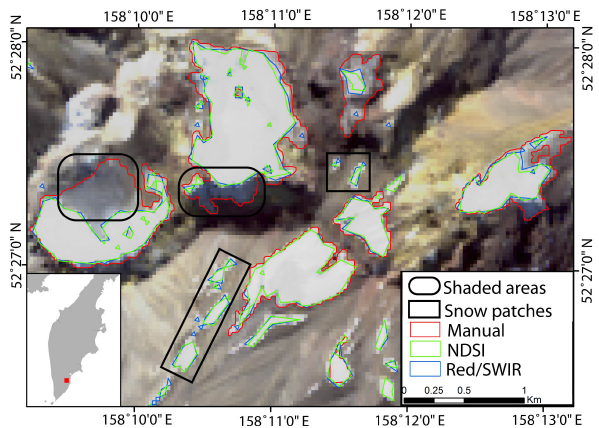
Figure 2. Comparison of glacier margins (on the slopes of Mut- novsky Volcano) delineated by two semi-automated techniques and manual mapping (Landsat 2014 background image). This figure il- lustrates how manual mapping can help identify snow patches and shaded areas of glacier ice, thereby allowing the former to be dis- counted from, and the latter included in, the glacier